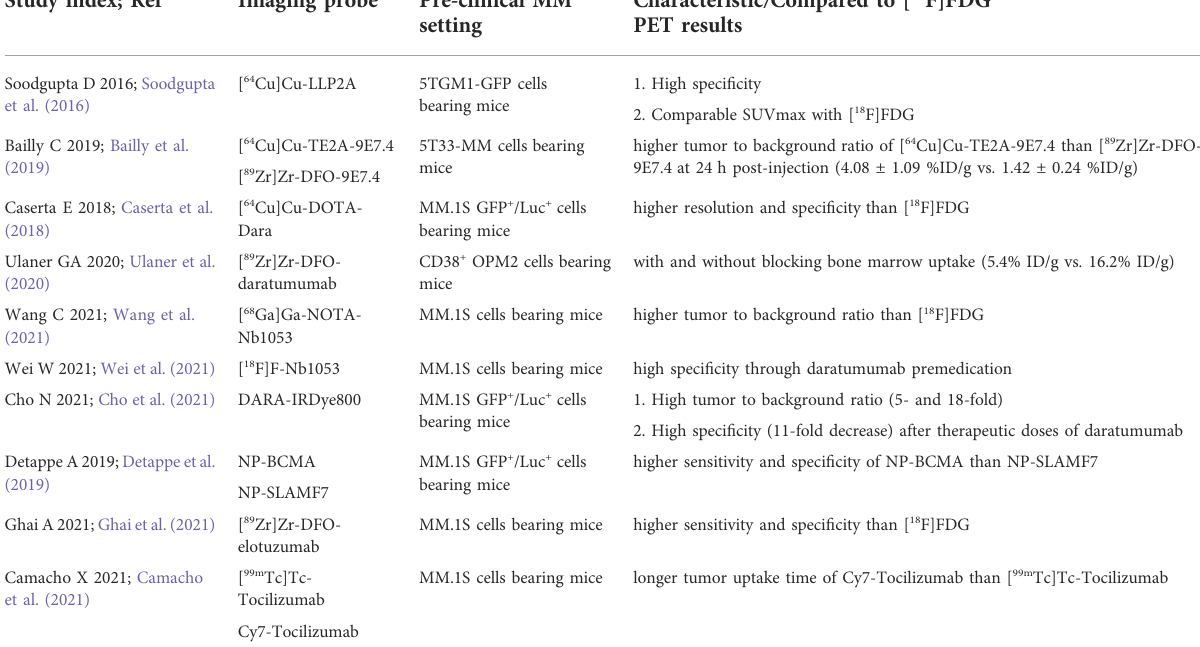
TABLE 3 Reported MM related imaging probe at pre-clinical evaluation